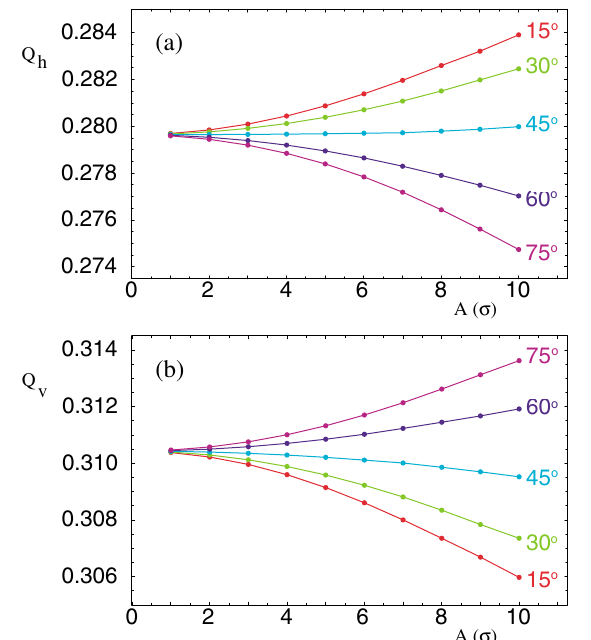
FIG. 3. (Color) Example (seed 39) of horizontal and vertical detuning versus amplitude for five initial angles. The upper and lower plots correspond to the horizontal and vertical planes, The lower plot shows corresponding results for the verti- cal plane. The error bars on the points indicate 1 standard deviation above the mean values, and the dashed lines indicate the maximum values.